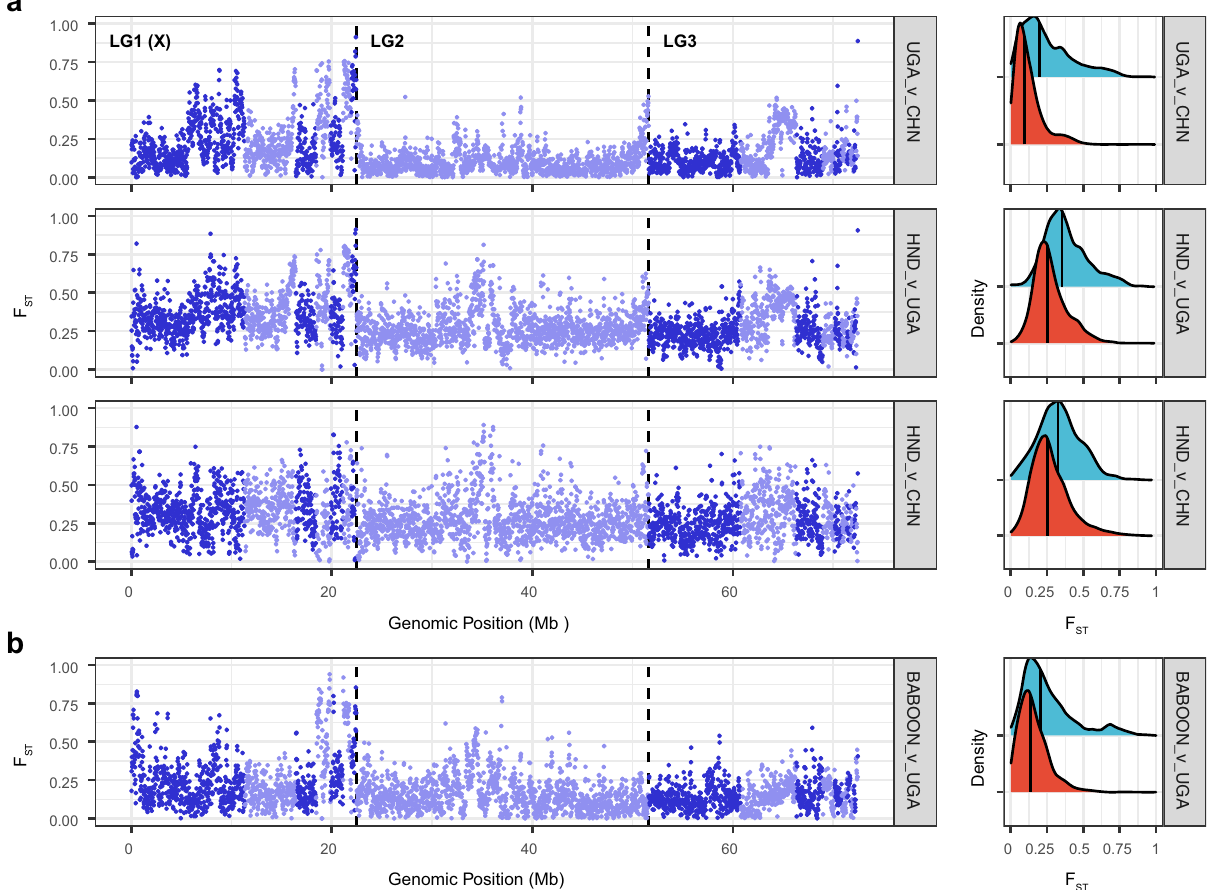
Fig. 4 Genome-wide comparison of genetic variation between populations. a Comparison of genome-wide genetic differentiation between human- infective T. trichiura from genetically and geographically de fi ned populations. Pairwise F ST was measured in 20 kb windows between China and Uganda (top), Uganda and Honduras (middle), and China and Honduras (bottom). Alternating dark and light blue colours represent different scaffolds, with the vertical dashed lines separating the three chromosomal linkage groups (LG). The sex-linked linkage group is indicated as LG1 (X). b Comparison of closely related human-infective Ugandan and baboon-infective T. trichiura . Sample abbreviations: CHN = China; UGA = Uganda; HND = Honduras. Density plots in a and b show the distribution of F ST values for the sex-linked (blue) and autosomal (red) scaffolds. The median F ST value for each is shown (solid vertical